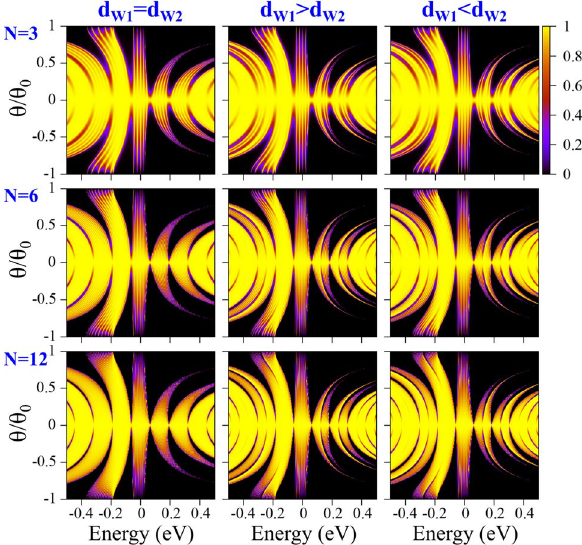
Figure 17. Transmission maps of BPGGSLs for different number of periods N as indicated. Here, the superlattice parameters are: (Left) d W 1 = d W 2 = 50 a , (Middle) d W 1 = 60 a and d W 2 = 50 a , and (Right) d W 1 = 50 a and d W 2 = 60 a . In all cases d B = 50 a and V 0 = 0.13 eV. Here, the angle of incidence is normalized to θ 0 = 90 ◦